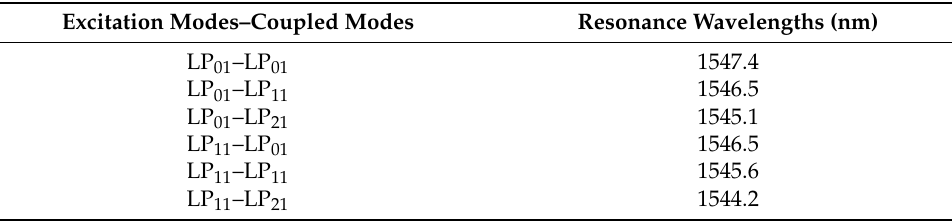
Table 1. The resonance wavelengths of coupled modes under different excitation modes.